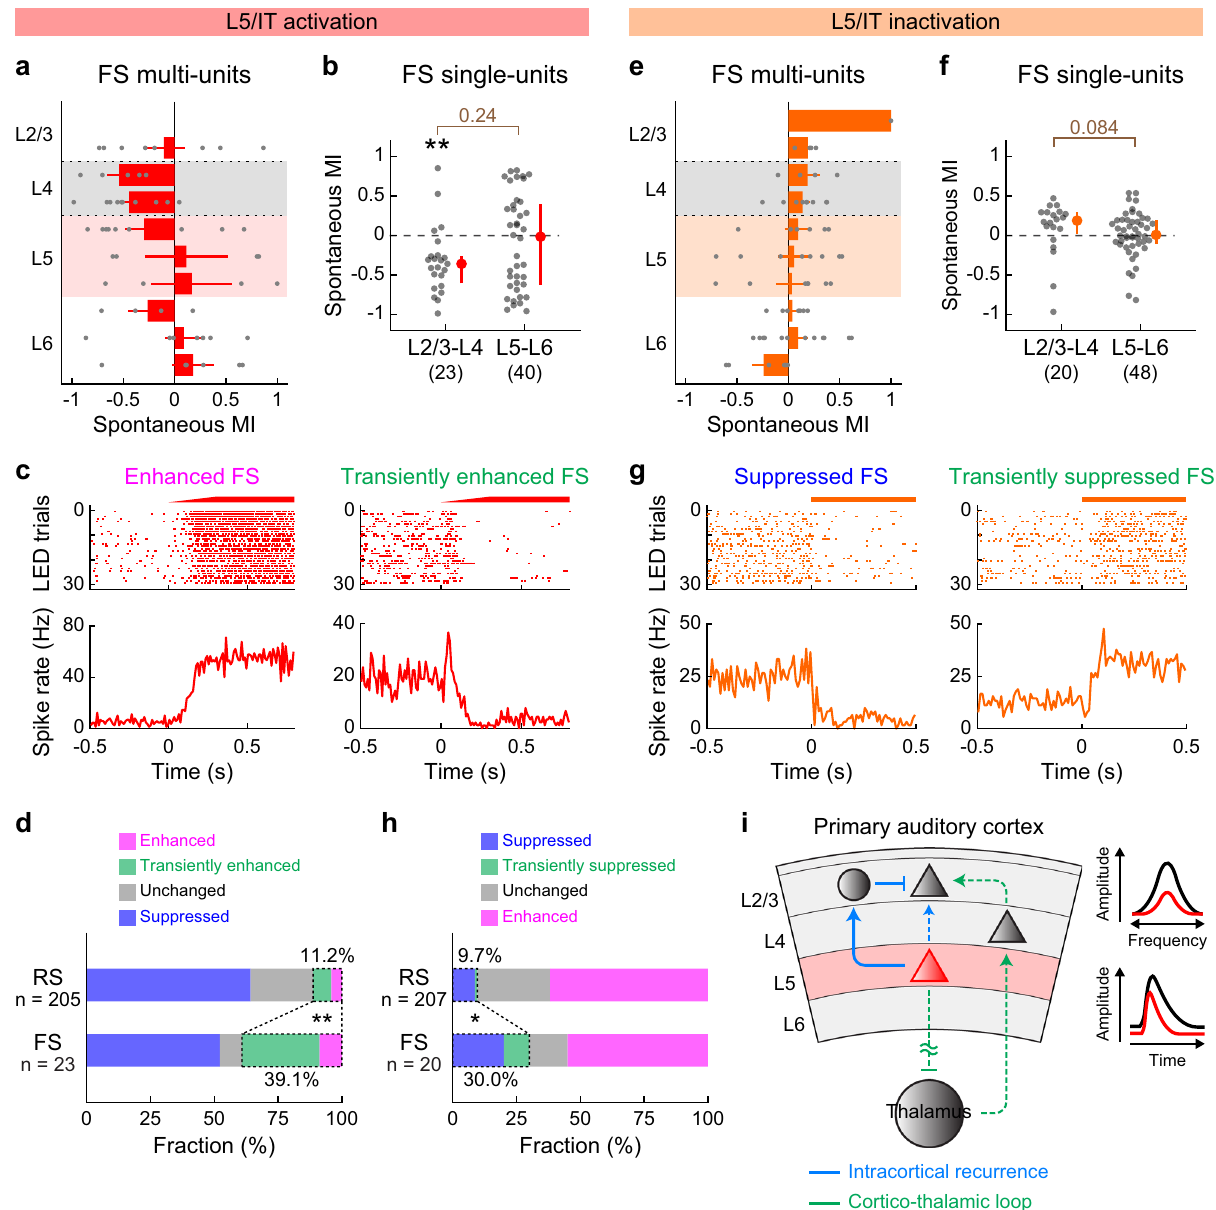
Fig. 7 L5 recurrent inputs preferentially recruit fast-spiking units in super fi cial layers. a – d Data for fast-spiking (FS) units during L5 activation with ChrimsonR, combining data from Rbp4-Cre and Tlx3-Cre mice. a Laminar pro fi le of MI for the spontaneous fi ring of FS multi-units during L5 activation overlaid with individual data points ( n = 16 mice). Depth is normalized in each mouse according to the surface, L4 borders, and white matter positions. Red shade indicates L5. Larger bins were used compared to RS units data due to the sparsity of FS units. Results are mean ± SEM. b Scatter plot showing MI for the spontaneous fi ring of FS single-units across mice ( n = 23 and 40 for L2/3 – L4 and L5 – L6). Red dots and bars represent median and 25th and 75th percentiles. ** p < 0.01. Individual groups: two-sided Wilcoxon signed rank test with Bonferroni correction (black asterisks). Comparisons across groups: two-sided Wilcoxon rank sum test (brown). c Raster and PSTH of representative L2/3 FS single-units showing sustained (left) or transient (right) enhancement of spontaneous fi ring during L5 activation. d Fraction of L2/3 – L4 RS and FS single-units showing sustained enhancement (pink), transient enhancement (green), suppression (blue), and no change (gray) (16 mice; RS, n = 205 units; FS, n = 23 units). ** p = 0.0015 (two-sided Fisher exact test). e – h Same as in a – d but for L5 inactivation with eNpHR3. e n = 19 mice. f n = 20 and 48 for L2/3 – L4 and L5 – L6. g Raster and PSTH of representative FS single-units showing sustained (left) or transient (right) suppression of spontaneous fi ring during L5 inactivation. h n = 19 mice; RS, n = 207 units; FS, n = 20 units. * p = 0.016 (two-sided Fisher exact test). i Schematic illustrating the translaminar inhibitory feedback from L5 that sharpens L2/3 sound- evoked responses in both frequency and time domains. See Supplementary Data 1 for additional statistics. Source data are provided as a Source Data fi